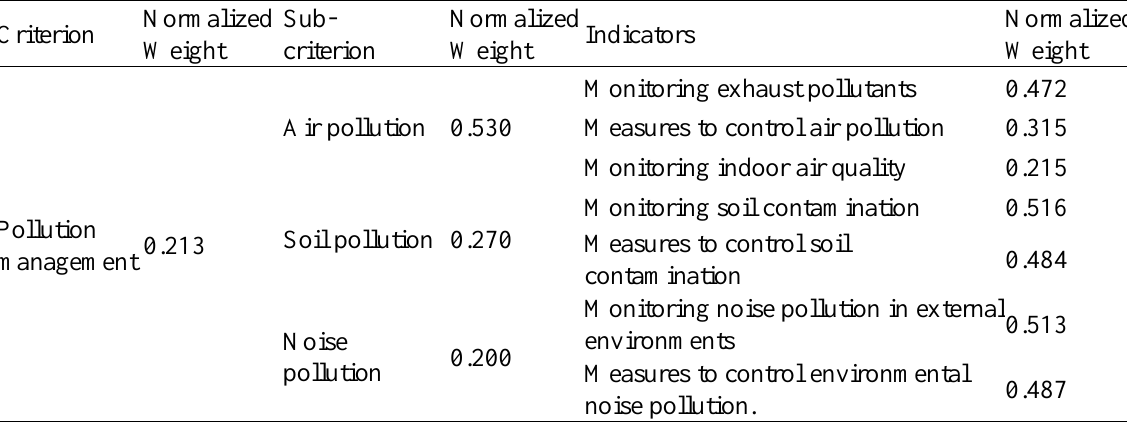
Table 4. Pollution sub-criteria, indicators and corresponding weights Criterion